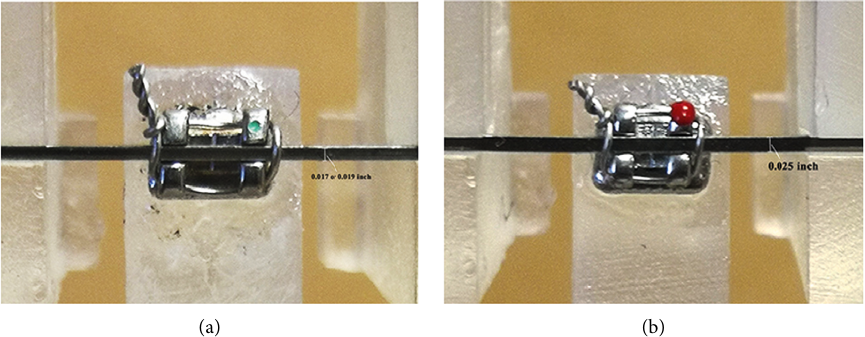
Figure 4: The conventional strength wire bracket (a) and the new ribbonwise bracket (b) are ligated in the OTS for testing using the experimental